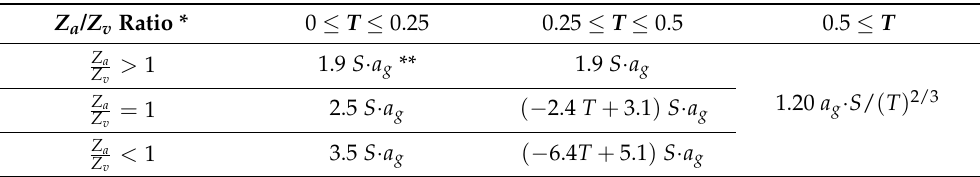
Table 2. Seismic acceleration values based on the national seismic standard